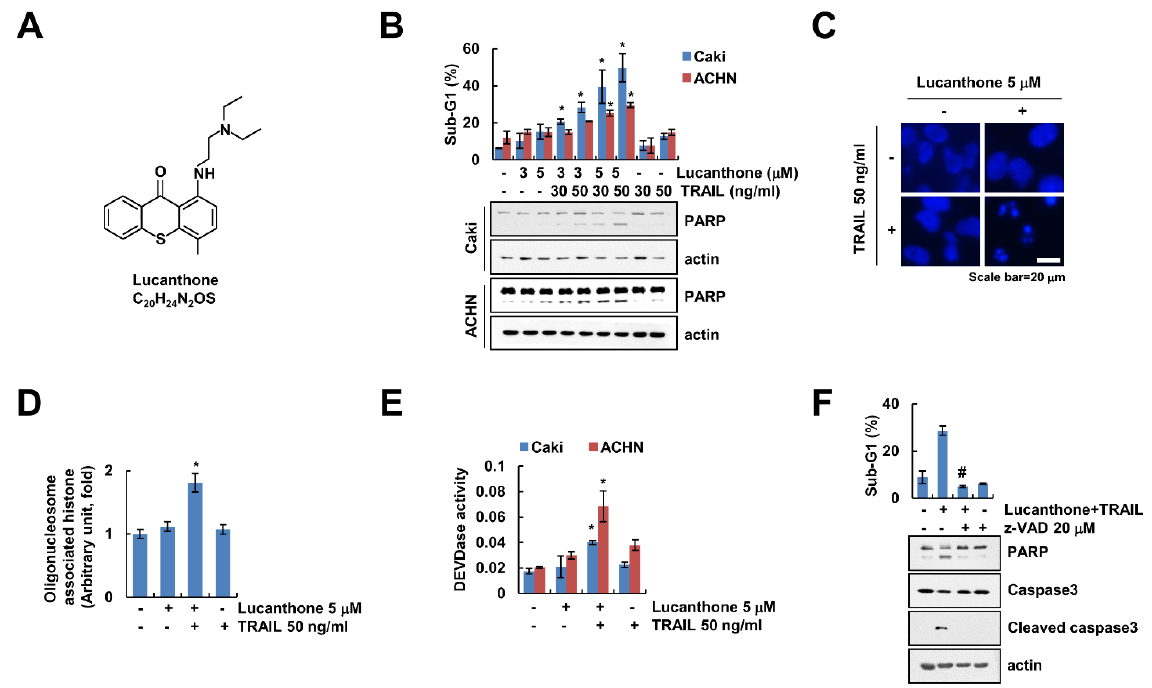
Figure 1. Lucanthone sensitizes TRAIL-induced apoptosis in human renal cancer cells. ( A ) Chemical structure of lucanthone (Formula: C 20 H 24 N 2 OS). ( B ) Caki and ACHN cells were treated with 3–5 μM lucanthone or/and 30–50 ng/mL TRAIL for 24 h; ( B–E ) Caki and ACHN cells were treated with 5 μM lucanthone or/and 50 ng/mL TRAIL for 24 h. ( C ) Condensation and ( D ) fragmentation of nuclei were examined using microscopy and DNA fragmentation assay kit, respectively. ( E ) DEVDase activity was examined using DEVDase substrate; ( F ) Caki cells were treated with 5 μM lucanthone and 50 ng/mL TRAIL for 24 h in the presence or absence of pretreatment with z-VAD for 30 min. The sub-G1 population and protein expression were measured by flow cytometry and Western blotting, respectively ( B,F ). The values in graph represent the mean ± SD of three independent samples. * p < 0.05 compared to the control. # p < 0.05 compared to the treatment of combinations of lucanthone and TRAIL.